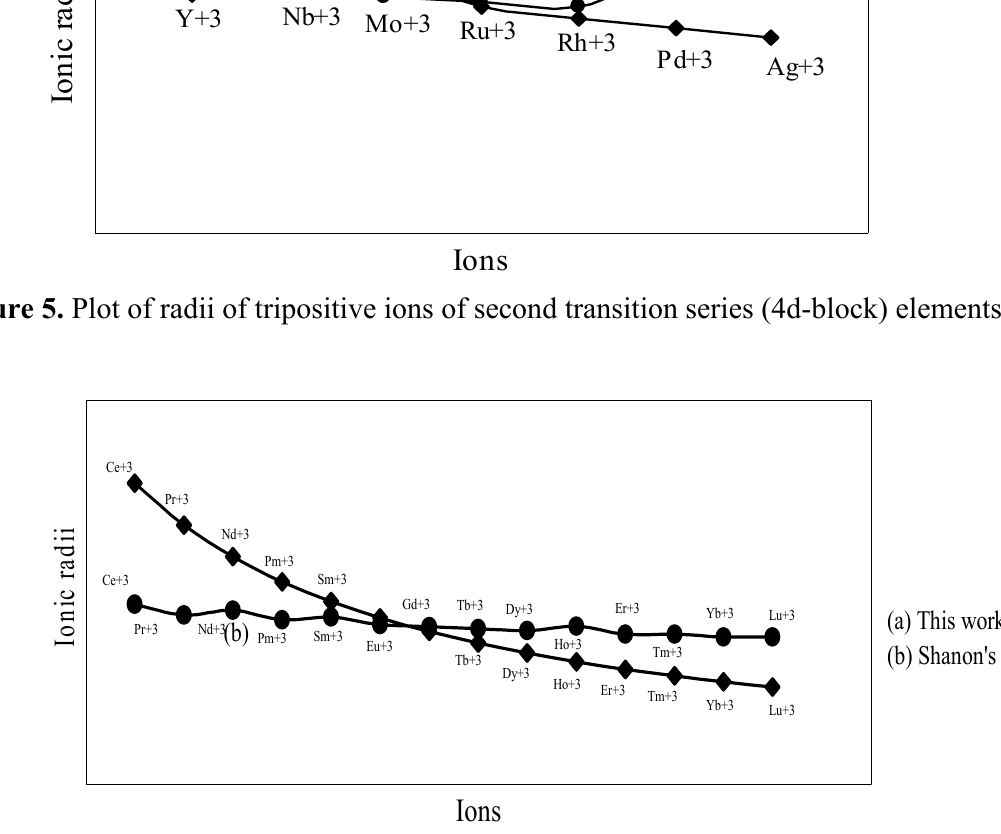
Figure 6. Plot of radii of tripositive ions of lanthanide (4f-block) elements